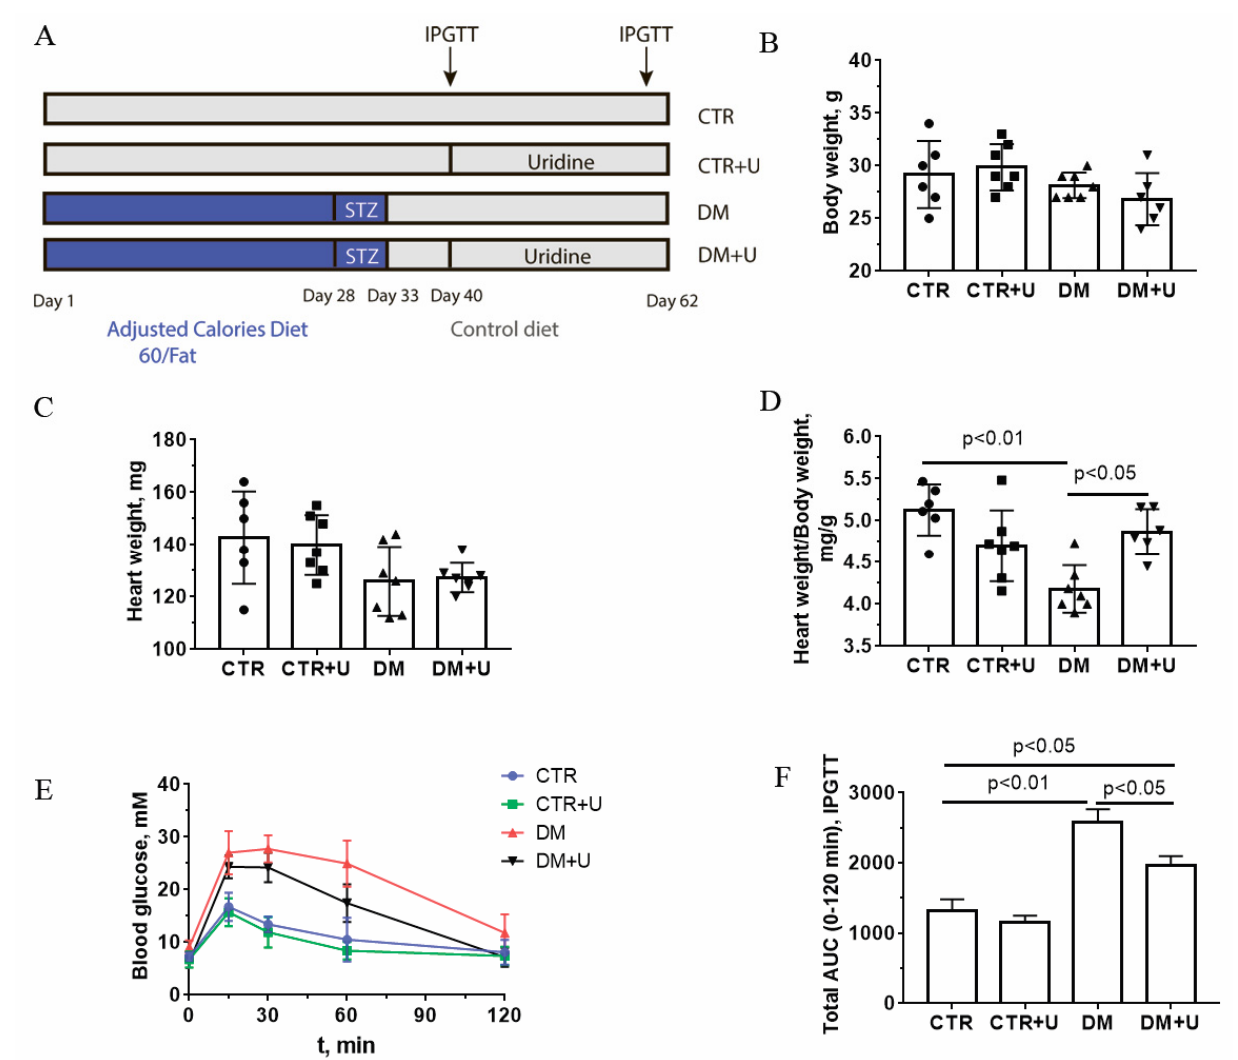
Figure 1. Scheme for induction of diabetes mellitus ( A ), body weight ( B ), absolute ( C ) and relative heart weight ( D ), intraperitoneal glucose tolerance test, IPGTT ( E ) in control (CTR), uridine-treated control (CTR + U), diabetic (DM), and uridine-treated diabetic (DM + U) C57BL/6 mice. The total areas under the curve (AUC) of the IPGTT ( F ). The tests were conducted on the 60th day from the beginning of the experiment. All data are presented as means ± SD ( n = 5–7).